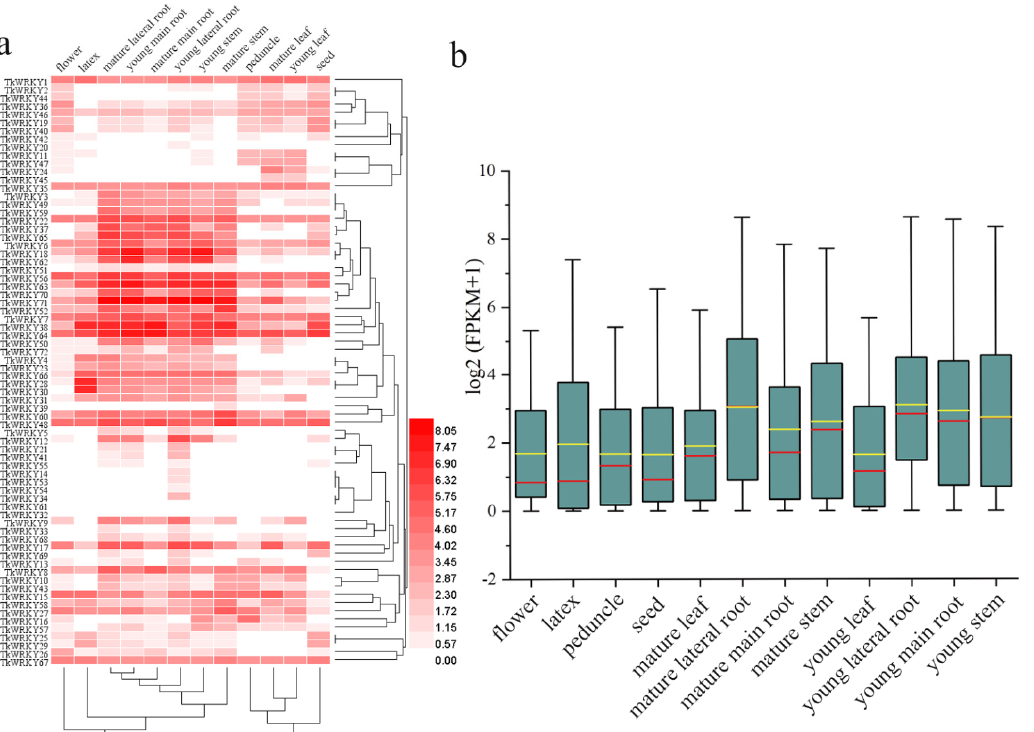
Figure 7. Expression profiling of TKS WRKY genes in 12 tissues of flower (FL), latex (LA), peduncle (PE), seed (SE), mature leaf (ML), mature lateral root (MLR), mature main root (MMR), mature stem (MS), young leaf (YL), young lateral root (YLR), young main root (YMR), and young stem (YS): ( a ) phylogenetic relationship clustering of the expression profiles of the WRKY genes from 12 tissues; ( b ) boxplots showing the dispersion of the WRKY genes expression profile in 12 tissues. Red and yellow represent the median line and average line, respectively.